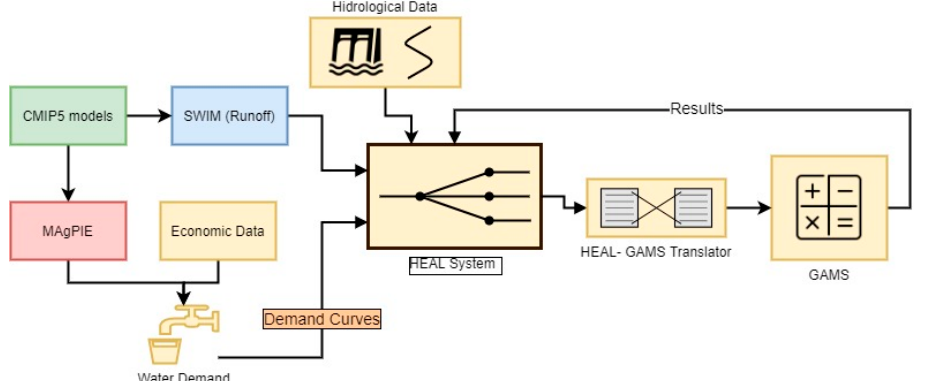
Figure A2. HEAL System: model chain and flow of information.